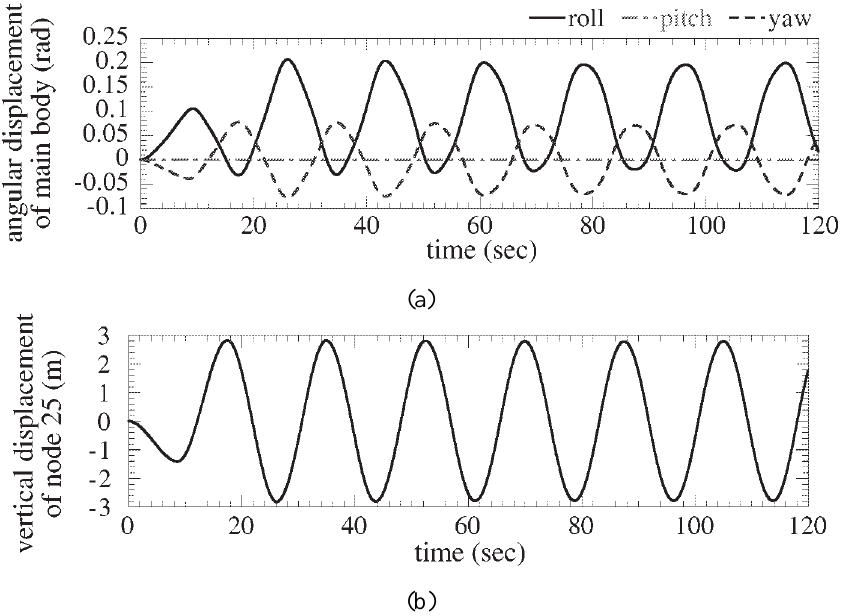
Fig. 6. Time responses under the bang-bang roll and yaw torque inputs: (a) attitude angle displacement of the main body, (b) vertical displacement measured in local reference frame of node 25 of solar panel.